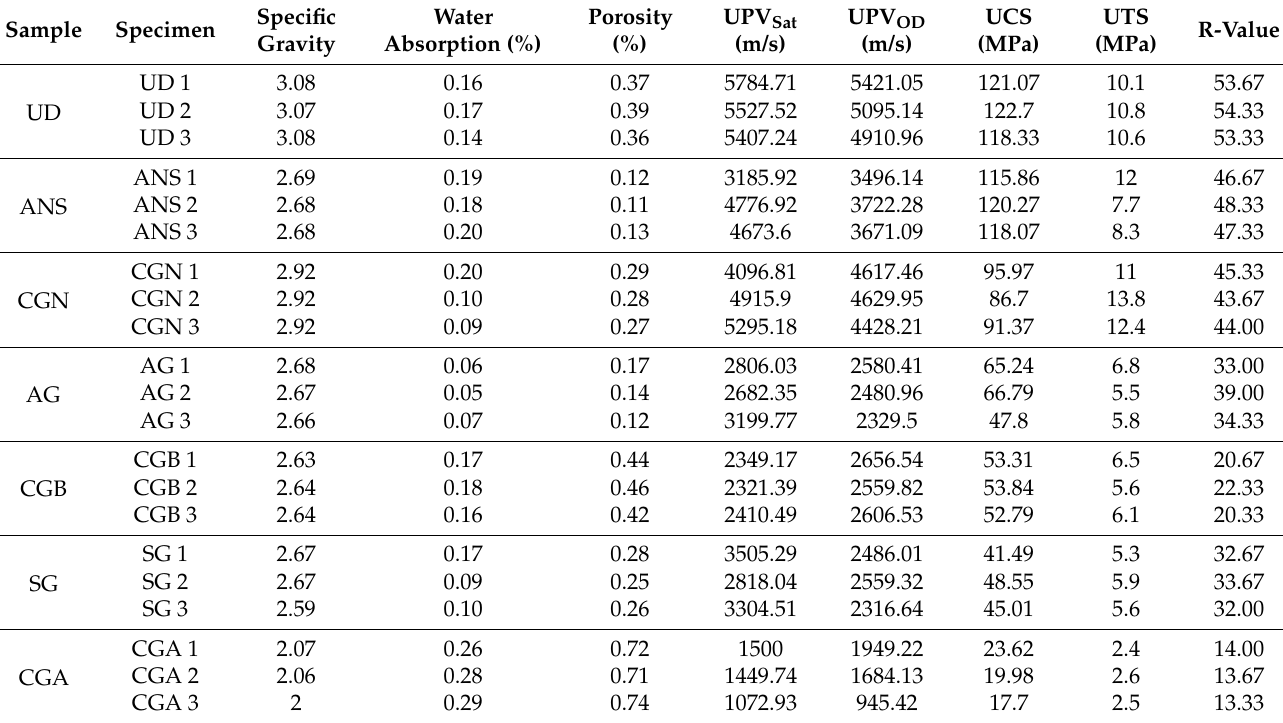
Table 4. Results of physical and strength properties of the investigated